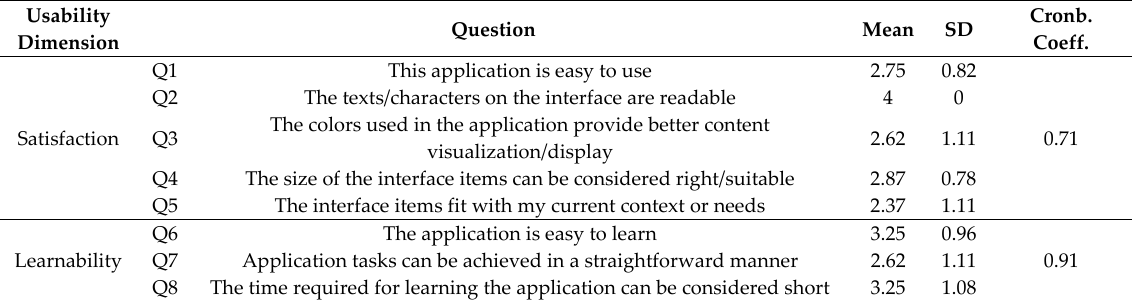
Table 4. Statistical results of the Mean, Standard Deviation, and Cronbach’s alpha